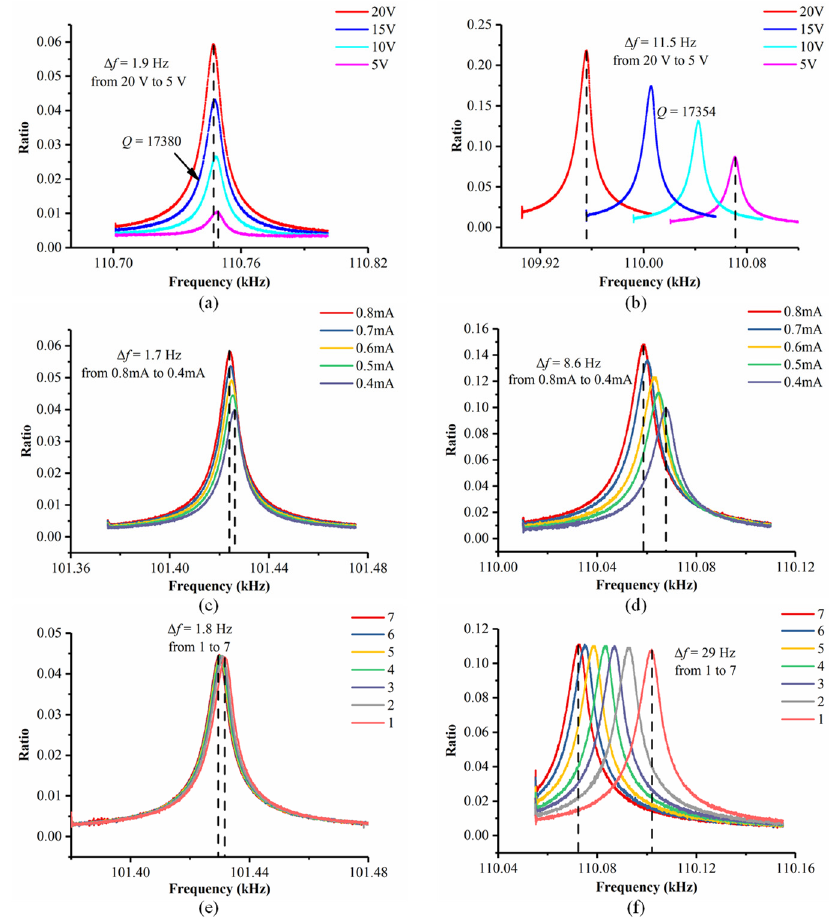
Figure 6. The frequency responses of resonators based on plate ( a ) and comb ( b ) drive under a group of exciting DC bias voltages. The frequency responses of resonators based on parallel-plate ( c ) and comb ( d ) drive under a group of testing currents. Multiple cycles of frequency responses of resonators based on parallel-plate ( e ) and comb ( f ) drive.